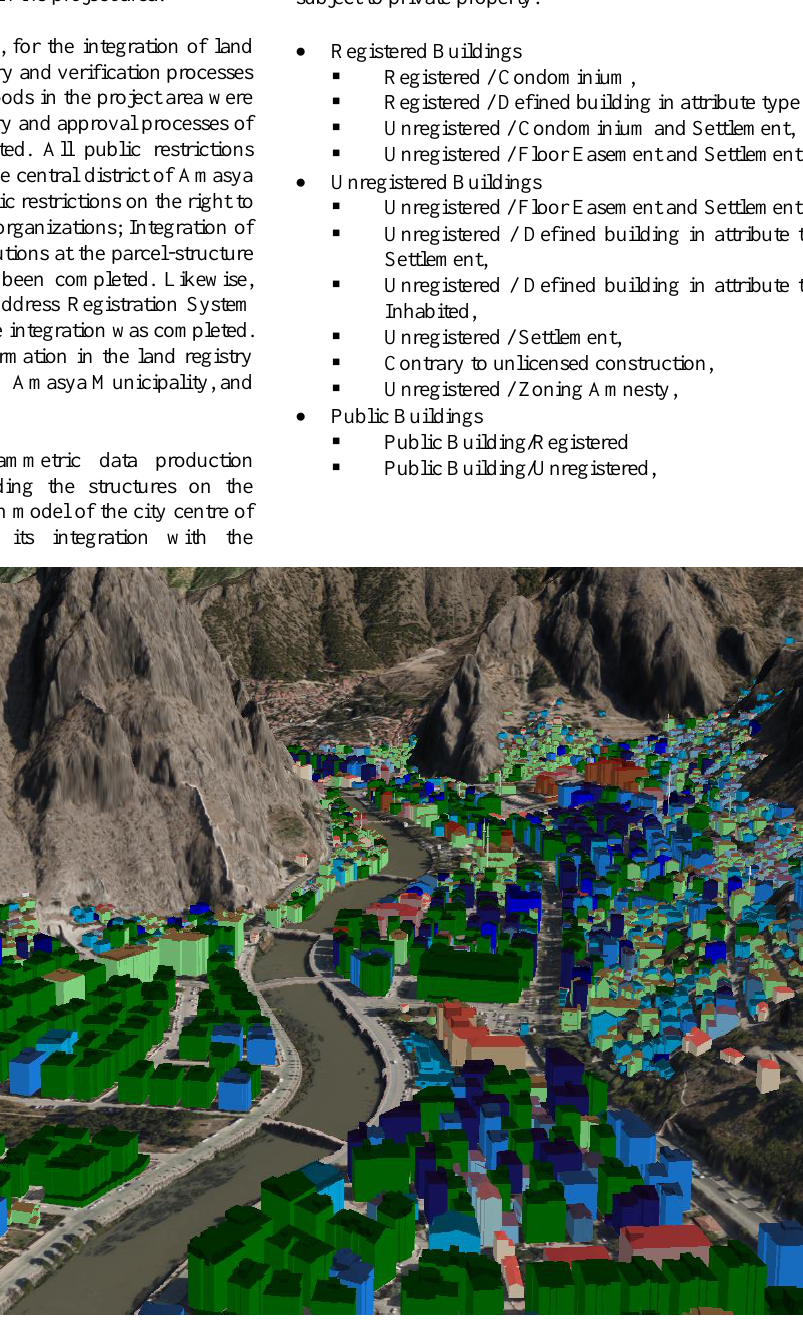
Figure 6. Building